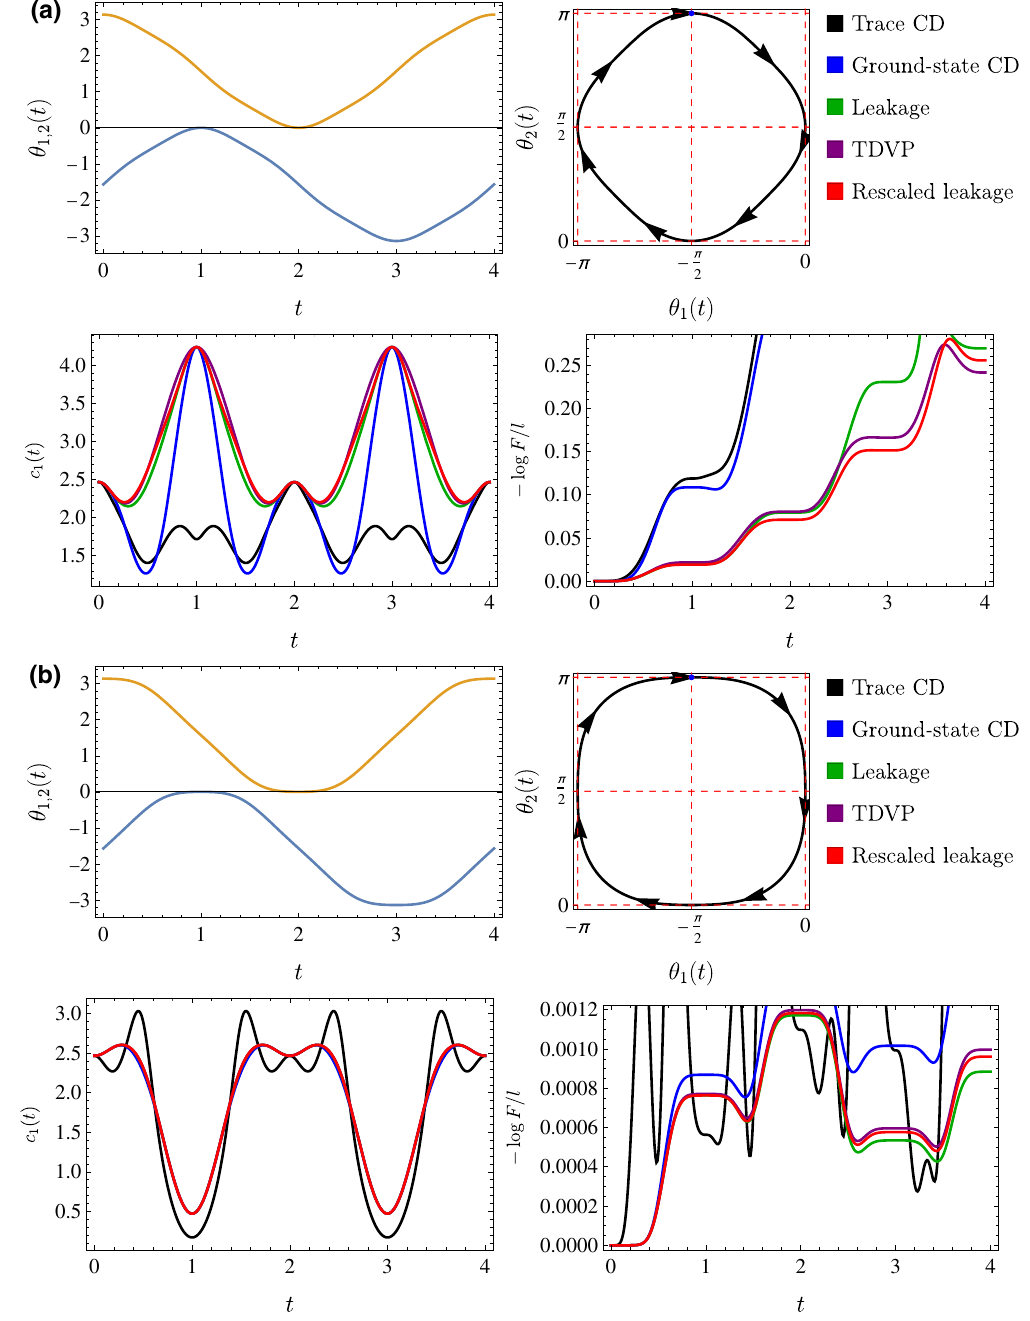
FIG. 7. We compare the performance of different approaches for the deformations of the circular trajectory marked in Fig. 4 with = + 0.05 in panel (a) and ε = − 0.05 in panel (b), and ε = 0 in both cases. In both examples, the leakage-based approaches ε 1 1 2 outperform ground-state CD that in turn outperforms trace CD. We observe that, when leakage, and in turn − log F / l , are small [see (b)], leakage minimization is the better approach. However, when this is not the case, as is shown in panel (a), the rescaled leakage approach appears to perform somewhat better. All data are obtained with infinite TEBD using a maximal bond dimension of χ = 512 and a time step of δ t = 10 − 5